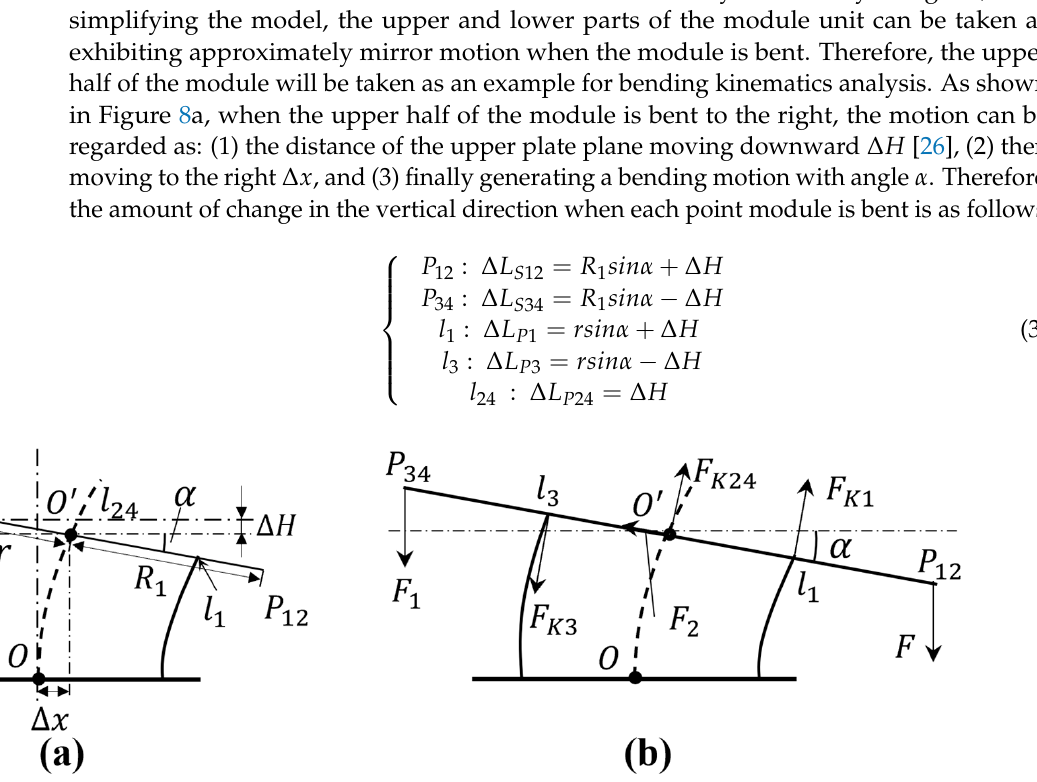
Figure 7. Two-dimensional model of the module. ( a ) A two-dimensional bending model of the module projected on Reference Plane 1. ( b ) Top view of the upper plate plane when the module is not bent.